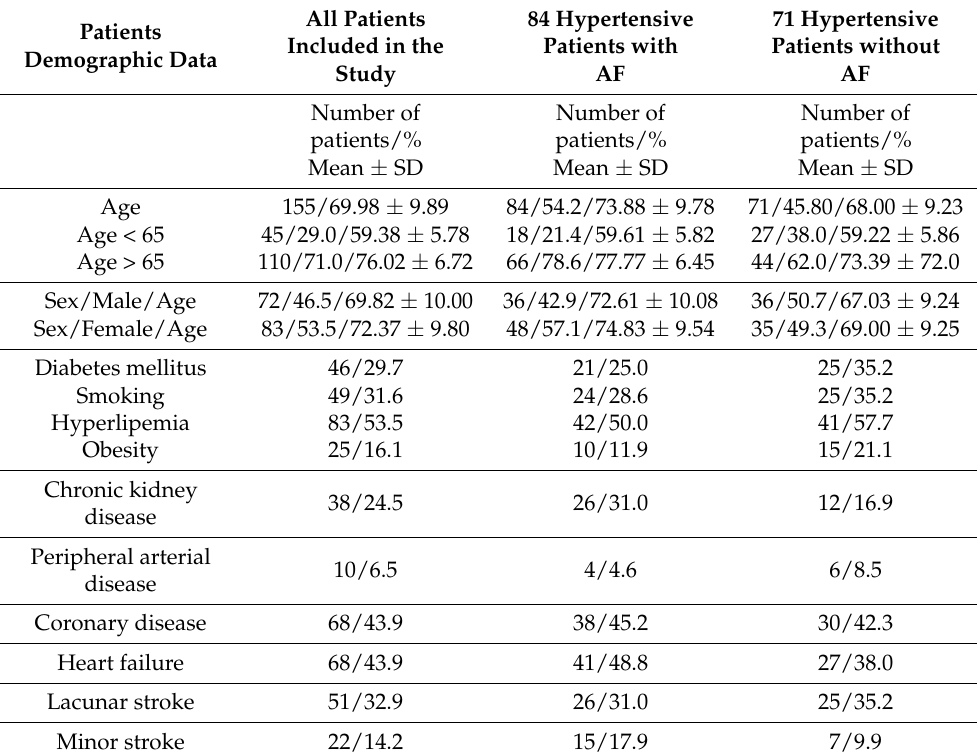
Table 1. Patient demographic data, cardiovascular risk factors